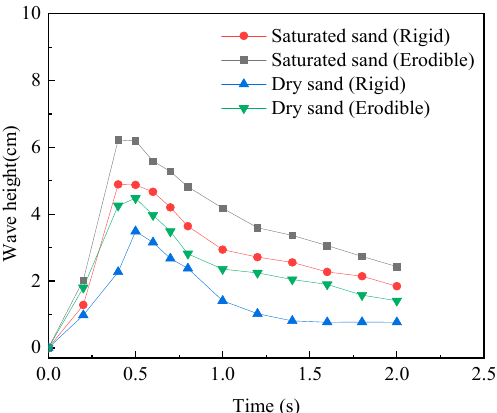
Figure 19. Temporal evolution of leading wave heights generated by granular landslides under different conditions.